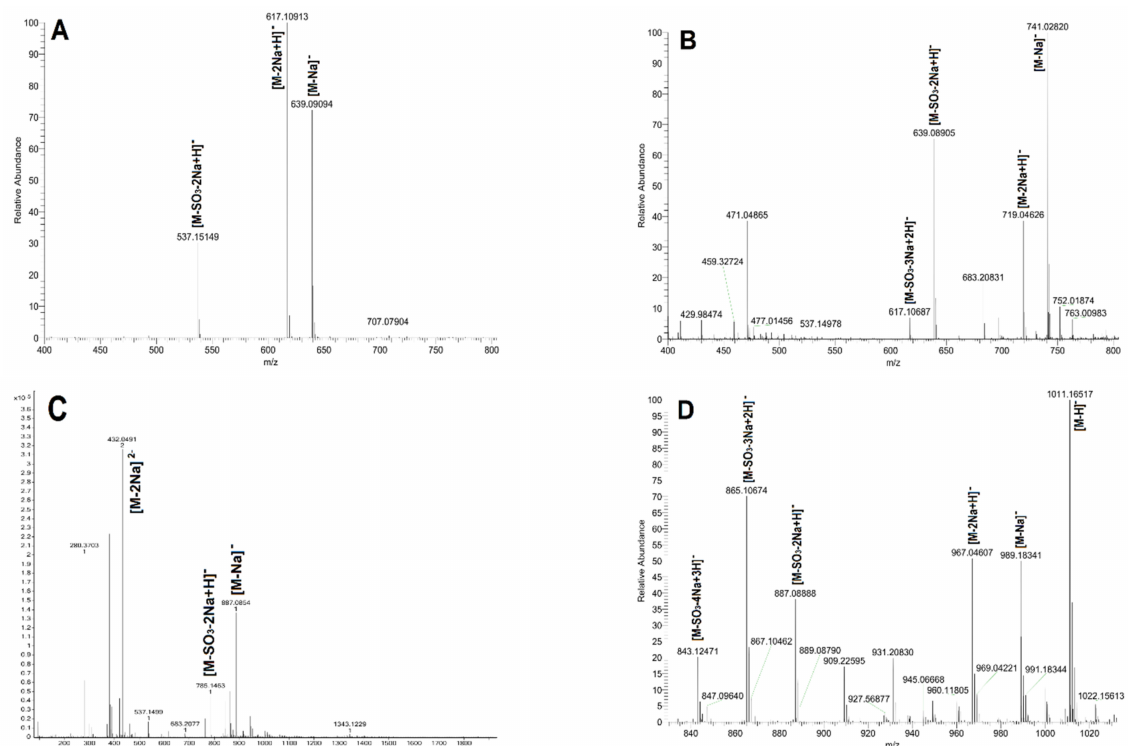
Figure 5. The mass spectrometry (MS) spectra of oligosaccharides FIII ( A ), FIV ( B ), FV ( C ) and FVI ( D